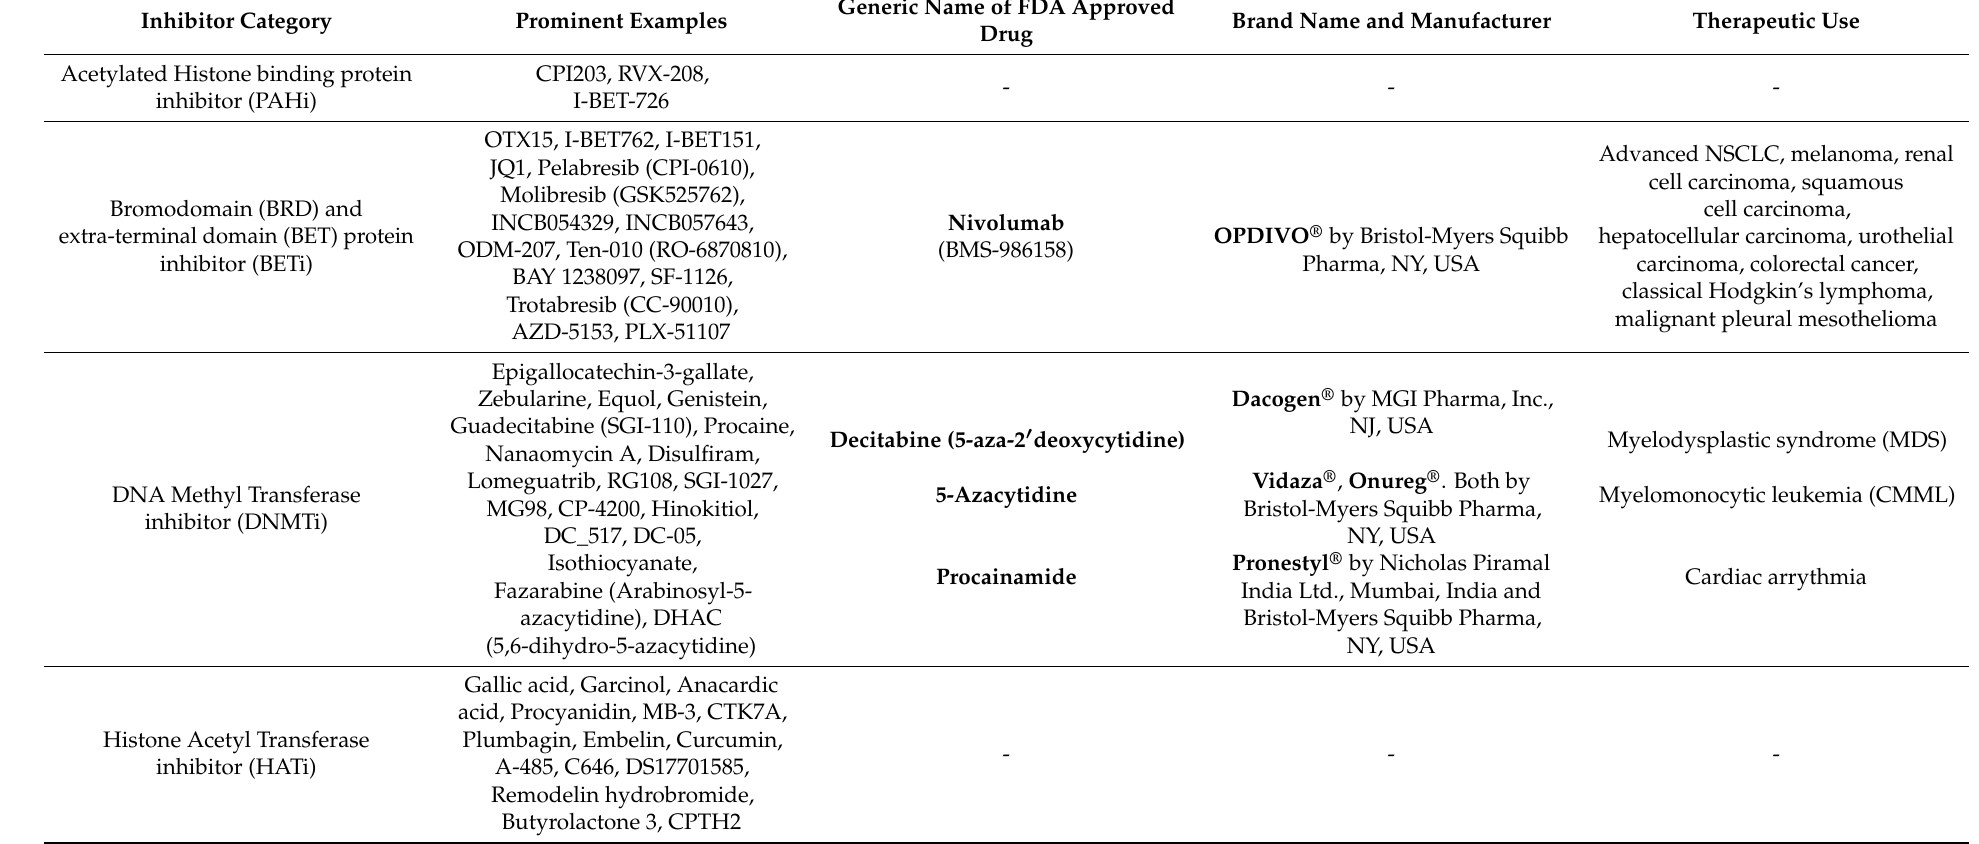
Table 3. List of epigenetic inhibitors and their approval status for clinical